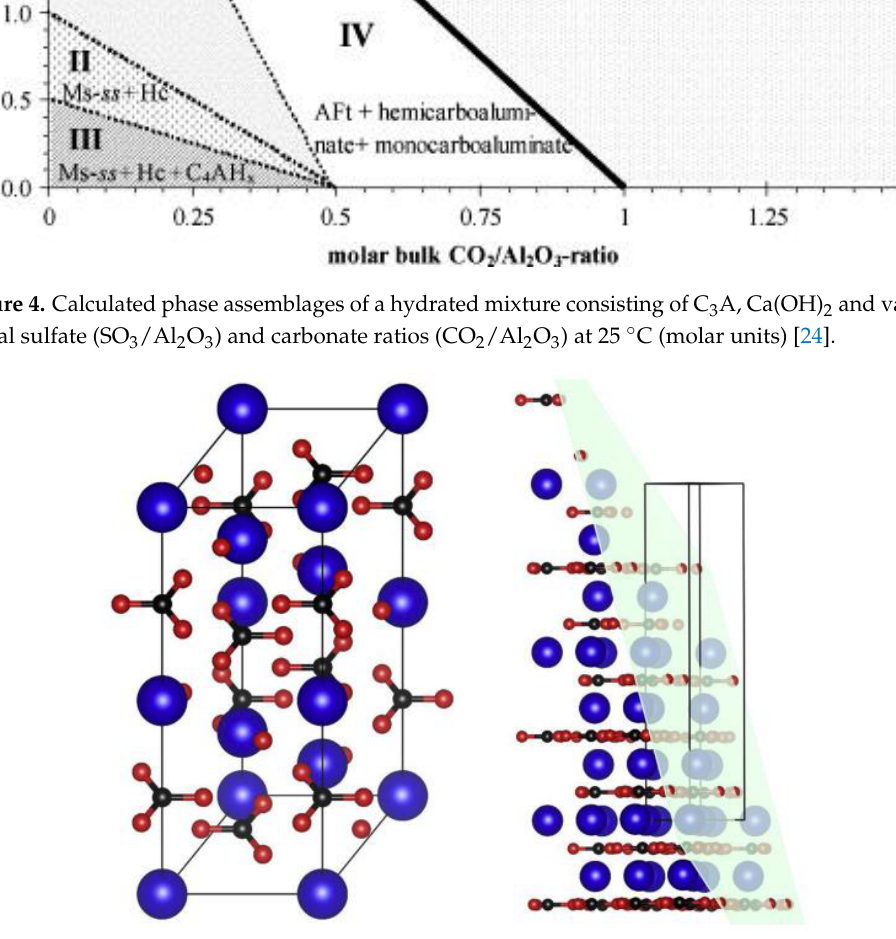
Figure 5. Calcite unit cell general view ( left ) and dissected by (101 — 4) plane ( right ). Atom radius is reduced from actual values to allow better visualization. (Ca: large blue atoms; C: small black atoms; O: small red atoms) [52].